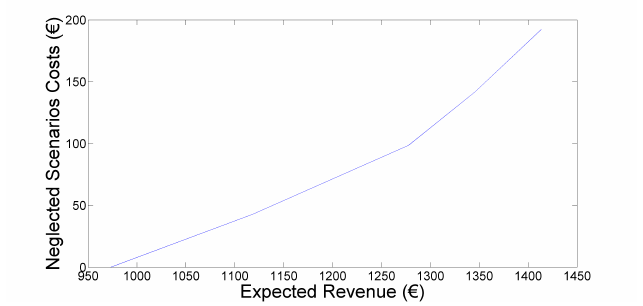
Figure 3. Expected costs for neglected scenarios vs. Expected